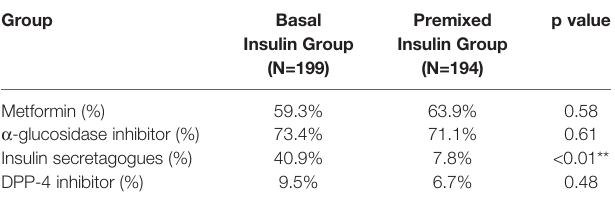
TABLE 2 | Drugs used in addition to insulin.